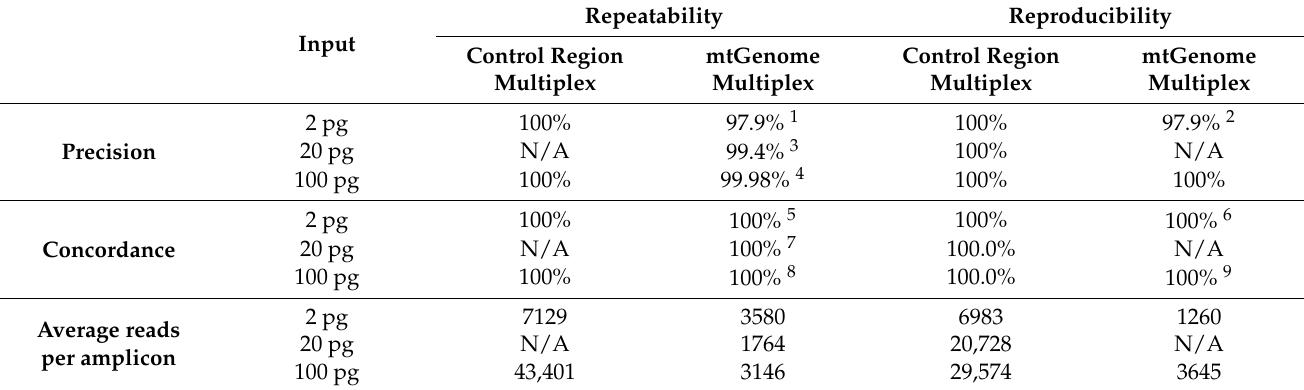
Table 4. Repeatability and reproducibility studies summary: control region and mtGenome